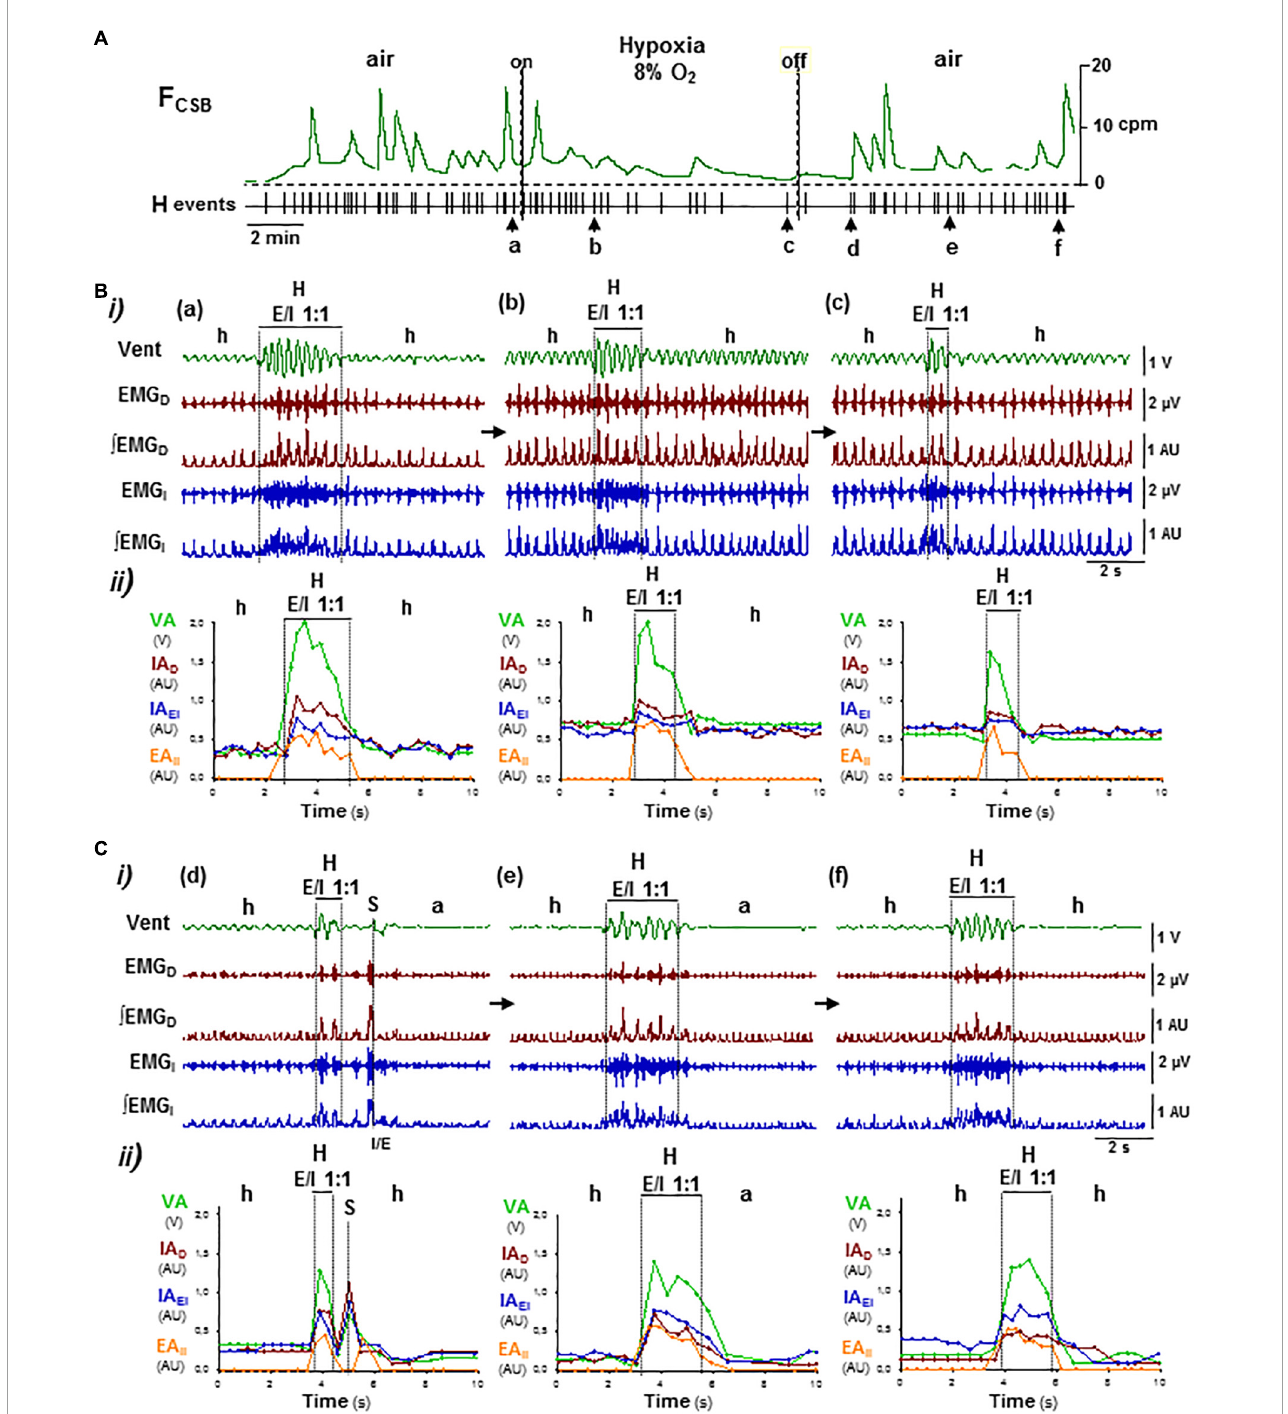
FIGURE7 Reconfiguration of CSB motor pattern induced by hypoxia–hypocapnia. Symbols as in Figure 5 . (A) Lowering O 2 content in the inhaled air from 21 to 8% did not suppress CSB but slowed its oscillatory frequency (FCSB). (B,C) Reconfigurations of CSB motor pattern during hypoxia stimulus ( a–c in B ) and reoxygenation ( d–f in C ). Hypoxic stimuli first increased and then decreased inspiratory motor activity and ventilation during the epochs of hypopnea and hyperpnea epochs, reducing the number of breathing cycles that expiratory/inspiratory coupling lasts while the profile of motor activities changed from crescendo–decrescendo to only decrescendo (a–c) . Reoxygenation provoked a long-lasting depression of inspiratory activity and ventilation during the epochs of apnea/hypopnea while expiratory–inspiratory coupling during hyperpnea epochs recovered (d–f) .